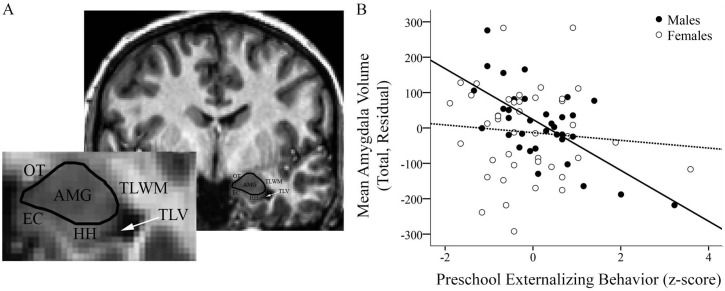
Greater externalizing behavior in preschool correlates with smaller male amygdala volume.A) Representative coronal view of the amygdala with key neuroanatomical landmarks denoted: AMG = amygdala; EC = entorhinal cortex; HH = hippocampal head; OT = optic tract; TLV = temporal horn of the lateral ventricle; TLWM = temporal lobe white matter. B) Correlation of preschool externalizing with amygdala volumes (upper panel: male r = -0.653, p = 0.000029; female r = -0.088, p = 0.578).